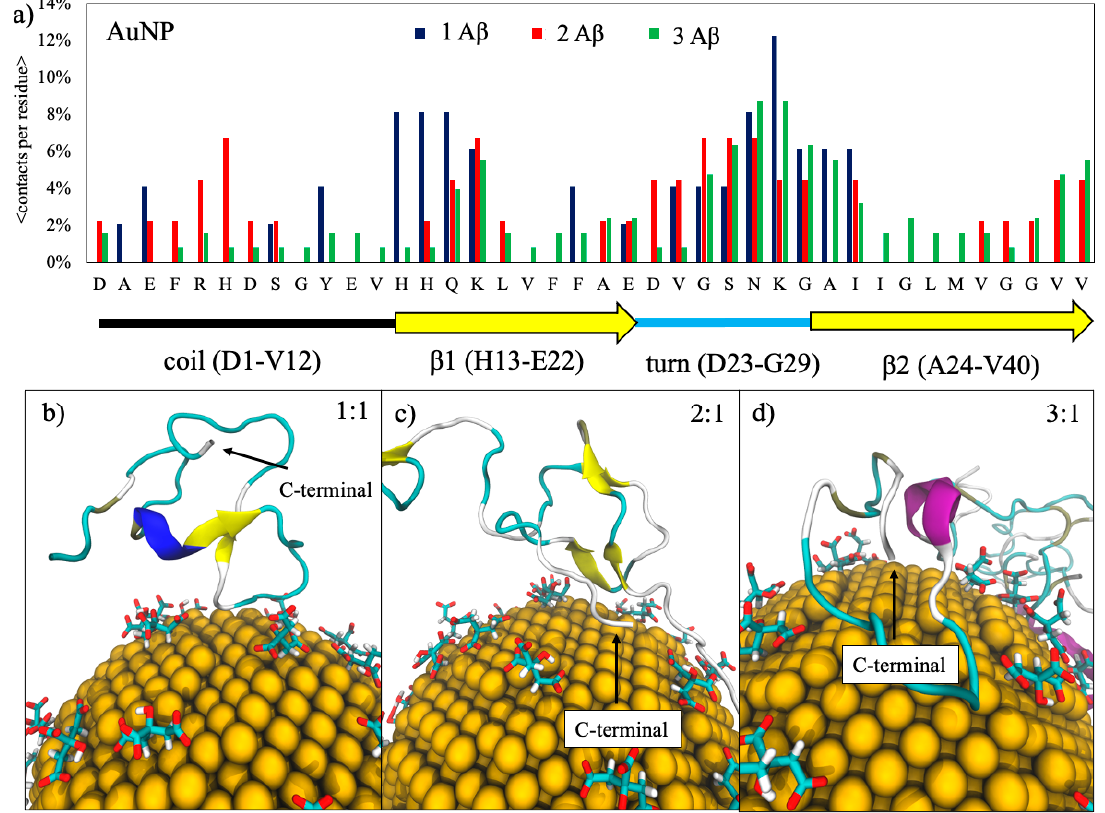
Figure 1. In panel ( a ), the contact probability of A β (1–40) peptide residues with the gold nanoparticles (AuNP) for each amyloid- β concentration studied. The dashed line represents the threshold that defines persistent contacts (contact is considered as persistent when a residue has a contact probability greater than 3%). The graphical representation of the secondary structure of the folded mature amyloid- β (1–40) is shown at the bottom of the figure. In panels ( b – d ), some representative snapshots of the adsorption of amyloid monomers onto citrate-capped AuNP at the three different ratios, respectively. Proteins are represented in cartoons colored accordingly to their secondary structures highlighting the C-terminal region.